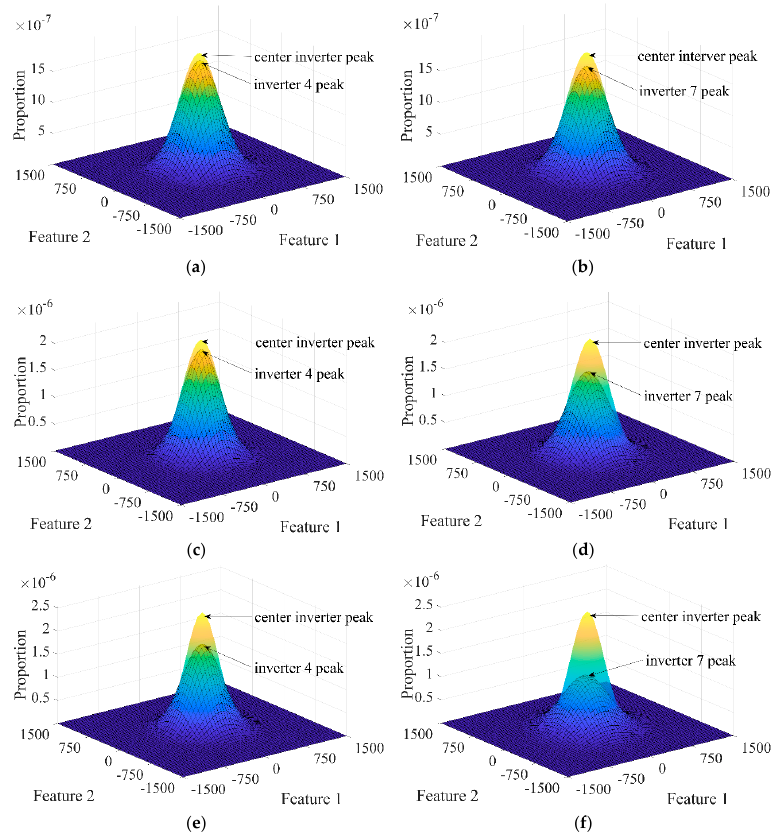
Figure 10. Gaussian mixture model between the center inverter and the PV inverter to be evaluated: ( a ) inverter 4 in May 2017; ( b ) inverter 7 in May 2017; ( c ) inverter 4 in November 2017; ( d ) inverter 7 in November 2017; ( e ) inverter 4 in April 2018; ( f ) inverter 7 in April 2018.